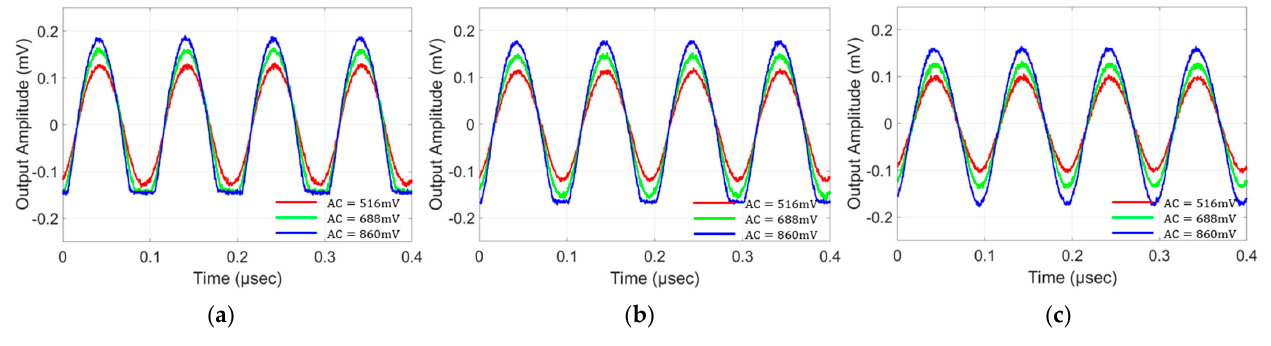
Figure 3. Dynamic response and linearity of the VCSEL; sine wave outputs for ( a ) 1.3 V DC bias, ( b ) 1.4 V DC bias and ( c ) 1.5 V DC bias.